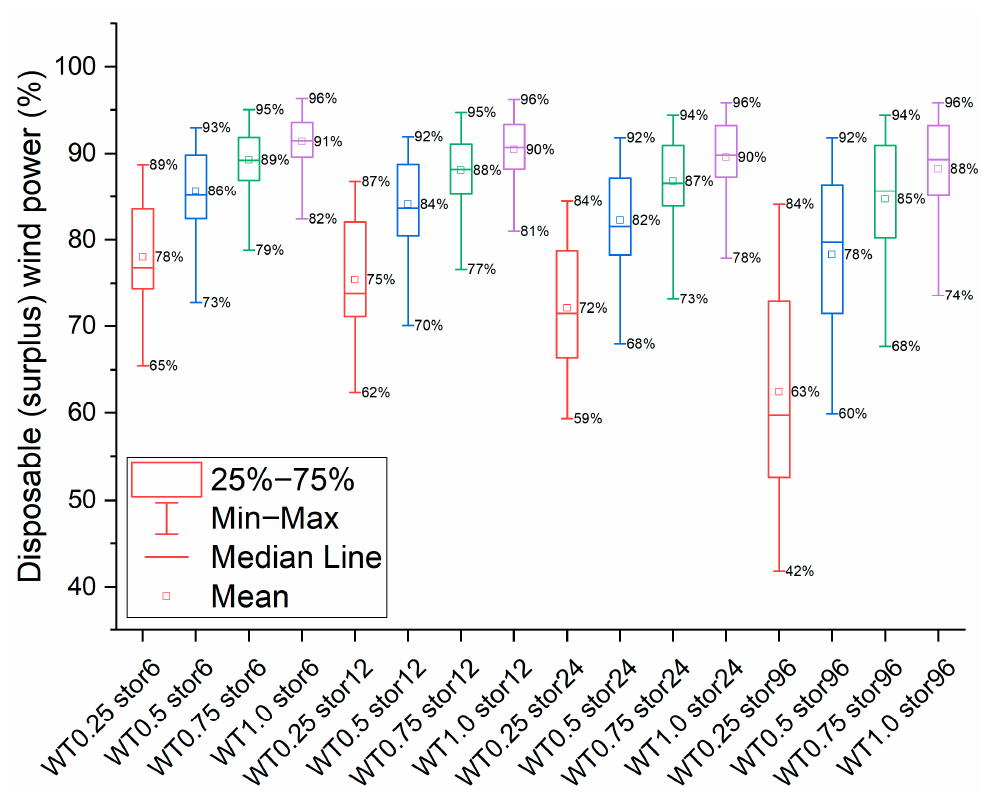
Figure 4. Ranges of curtailed wind power for various configurations of wind turbines and heat storage sizes over 37 consecutive years of observation. Geothermal source capacity equals 0.5. Labels explanation–see Figure 3. Units used in the graph are extensively explained in Appendix A.